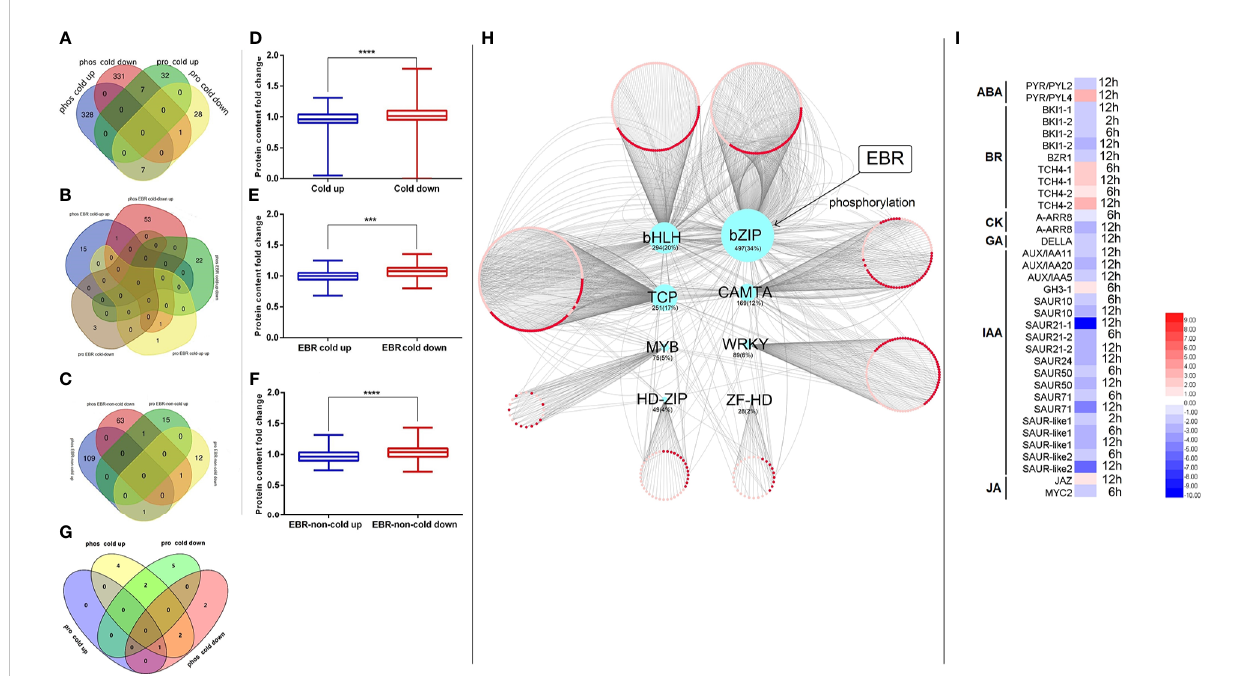
FIGURE 6 The association analysis of the transcriptome, proteome, and phosphoproteome. (A) The Venn of cold-responsive phosphopeptides and cold- responsive proteins; (B) the Venn of EBR-regulated cold-responsive phosphopeptides and EBR-regulated cold-responsive proteins; (C) the Venn of EBR-regulated non-cold-responsive phosphopeptides and EBR-regulated non-cold-responsive proteins; (D) the cold-responsive protein content between cold-up and cold-down phosphoproteins; (E) the EBR-regulated cold-responsive protein content between EBR-upregulated cold and EBR-downregulated cold-responsive phosphoproteins; (F) the EBR-regulated non-cold protein content between EBR-upregulated non-cold and EBR-downregulated non-cold phosphoproteins; (G) the Venn of KEGG pathway between differential phosphoproteins and proteins; (H) the network construction of cold TFs and its corresponding cold target mRNA; and (I) the expression of hormone signaling pathway genes under cold stress. The "***" indicates signi fi cantly different (p < 0.001 by Tukey ’ s test), and "****" indicates signi fi cantly different (p < 0.0001 by Tukey ’ s